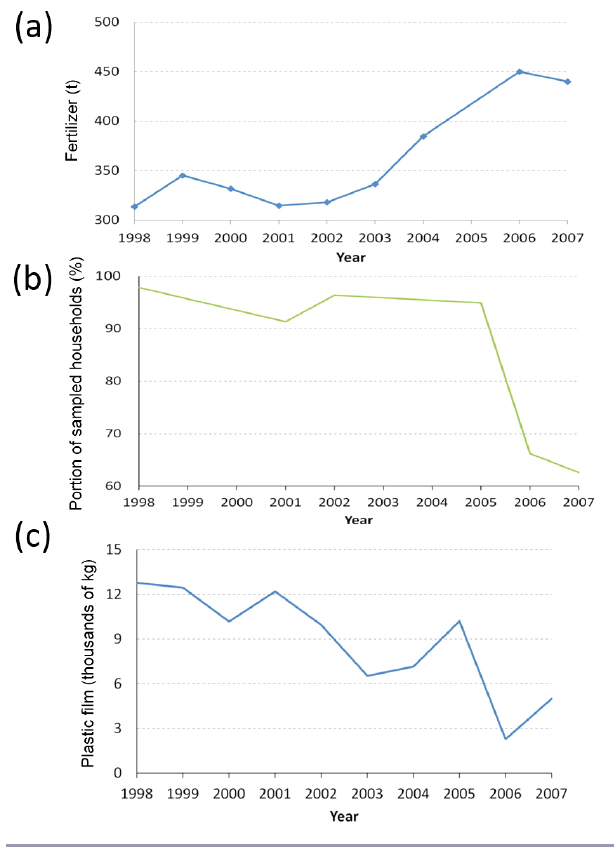
Fig. 7 . (a) Total amount of fertilizers purchased by Wolong farmers from outside markets over time. (b) Percentage of sampled households purchasing fertilizers over time. (c). Total amount of plastic film purchased by Wolong farmers over